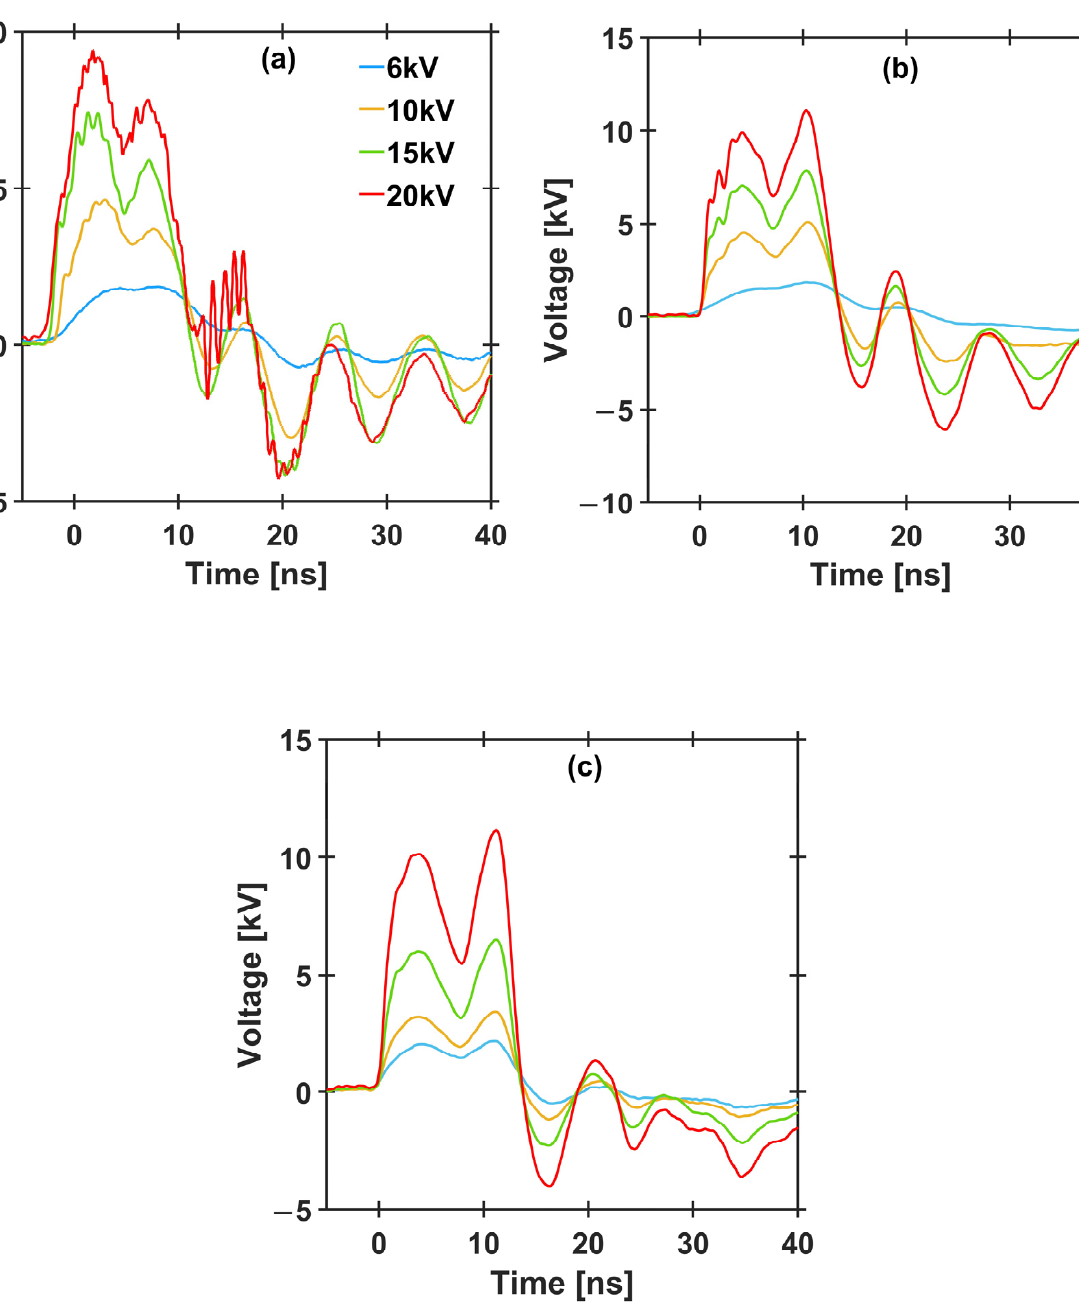
Figure 3. Output voltage waveforms for the ( a ) 10 Ω , ( b ) 25 Ω , and ( c ) 50 Ω NLTLs as combined PFL/HPM sources for different charging voltages.